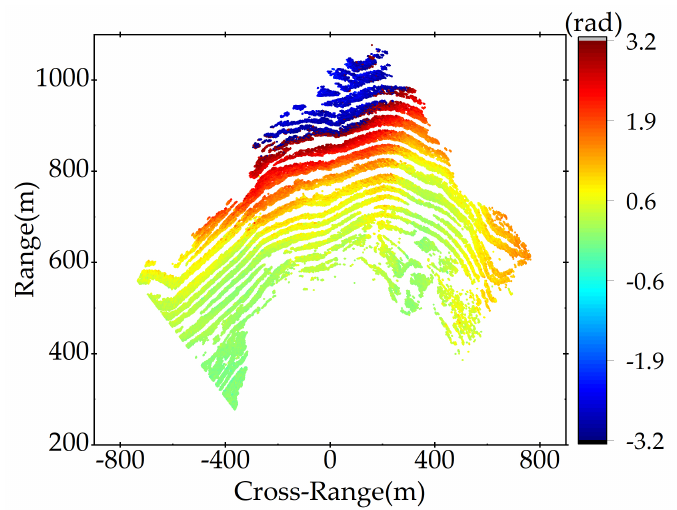
Figure 3. An interferogram with spatial phase wrapping, only PSs are